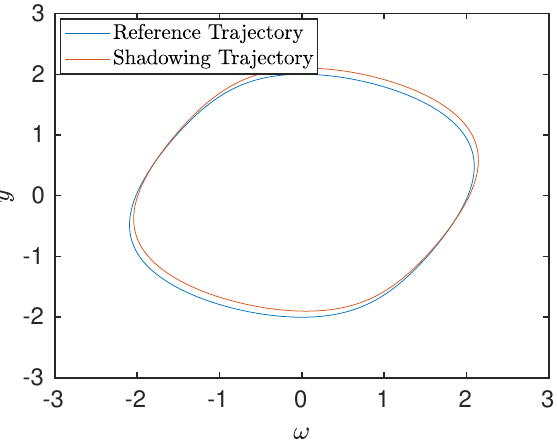
Figure 13. Shadowing and reference trajectory. Here, β ref = 0.3, β shad = 0.301, and T =